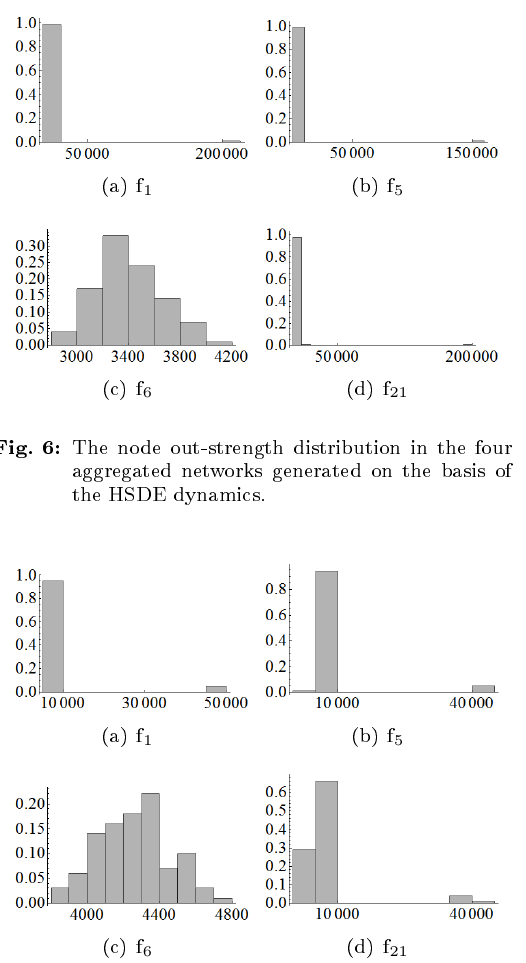
Fig. 7: The node out-strength distribution in the four aggregated networks generated on the basis of the JADE